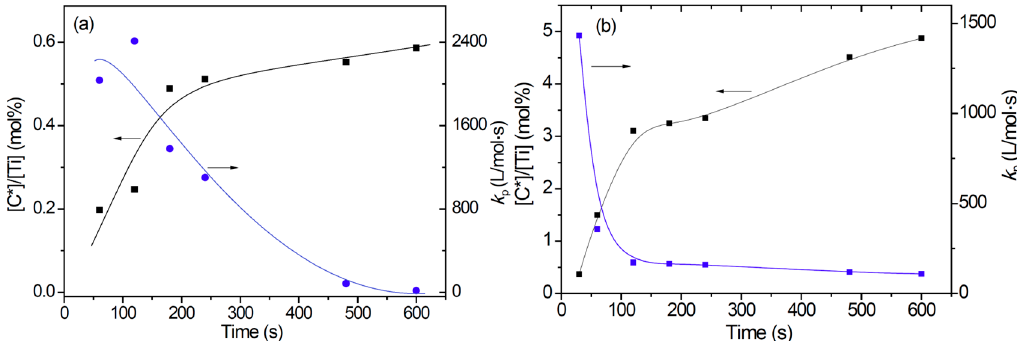
Figure 1. ( a ) Influence of polymerization time on the fraction of active centers and apparent propagation rate constant of ethylene polymerization; ( b ) influence of polymerization time on the fraction of active centers and apparent propagation rate constant of propylene polymerization.